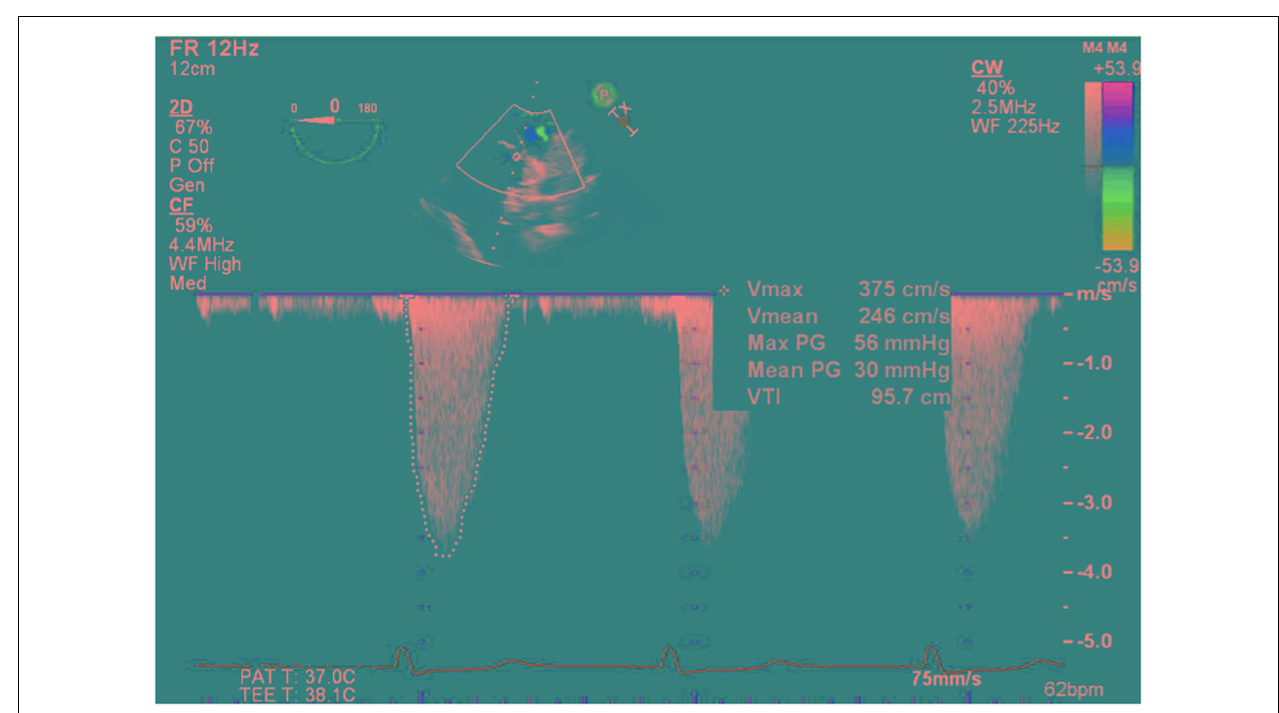
FIGURE 5 | Deep transgastric view continuous-wave Doppler through the unicuspid aortic valve showing gradients across the valve (peak/mean gradients = 56/30mmHg, Peak velocity of 3.75m/s,VTI = 96cm).